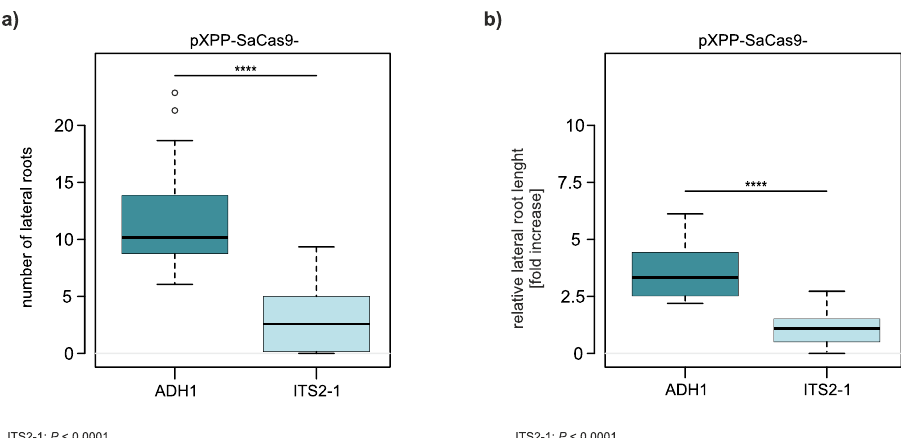
Fig. 7 CRISPR-Kill-mediated lateral root elimination in T2 lines by cleavage of 45S rDNA. a Total number of lateral roots in control line and rDNA CRISPR-Kill lines. The control line, pXPP-SaCas9-ADH1, showed an average of 11 lateral roots per plant, whereas the ITS2-1-CRISPR-Kill line showed a 3-fold decrease and only an average of 3 lateral roots per plant. P < 0.0001. b Lateral root length in relation to main root length. A 3-fold decrease could also be observed in the relative lateral root length of the ITS2-1-CRISPR-Kill line. While the sum of the length of all lateral roots in the control line was on average 3.6 times longer than the main root, the sum of the length of all lateral roots in the ITS2-1 CRISPR-Kill line was on average only 1.1 times longer than the main root. P < 0.0001. Data is presented as box plots ( n = 30), boxes show the fi rst to third quartile with median, whiskers encompass 1.5x the interquartile range reaching to minimum and maximum, and data beyond that threshold is indicated as outliers. P values were calculated using the